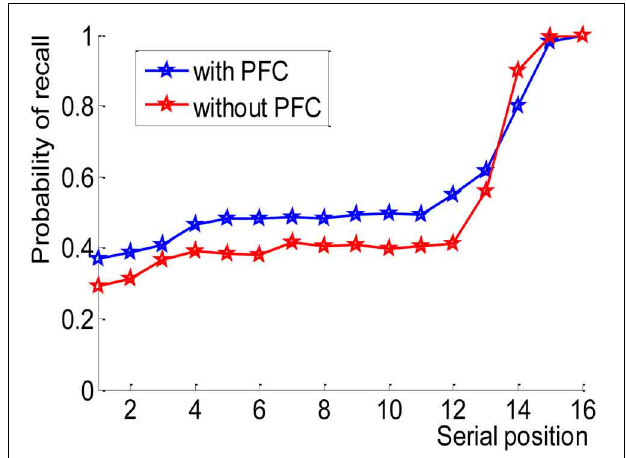
FIGURE 6 | Probability of recall of a CVLT—like list, red: model without the frontal mechanisms, blue: model which includes the frontal mechanisms. The frontal mechanisms enhance recall of a categorized